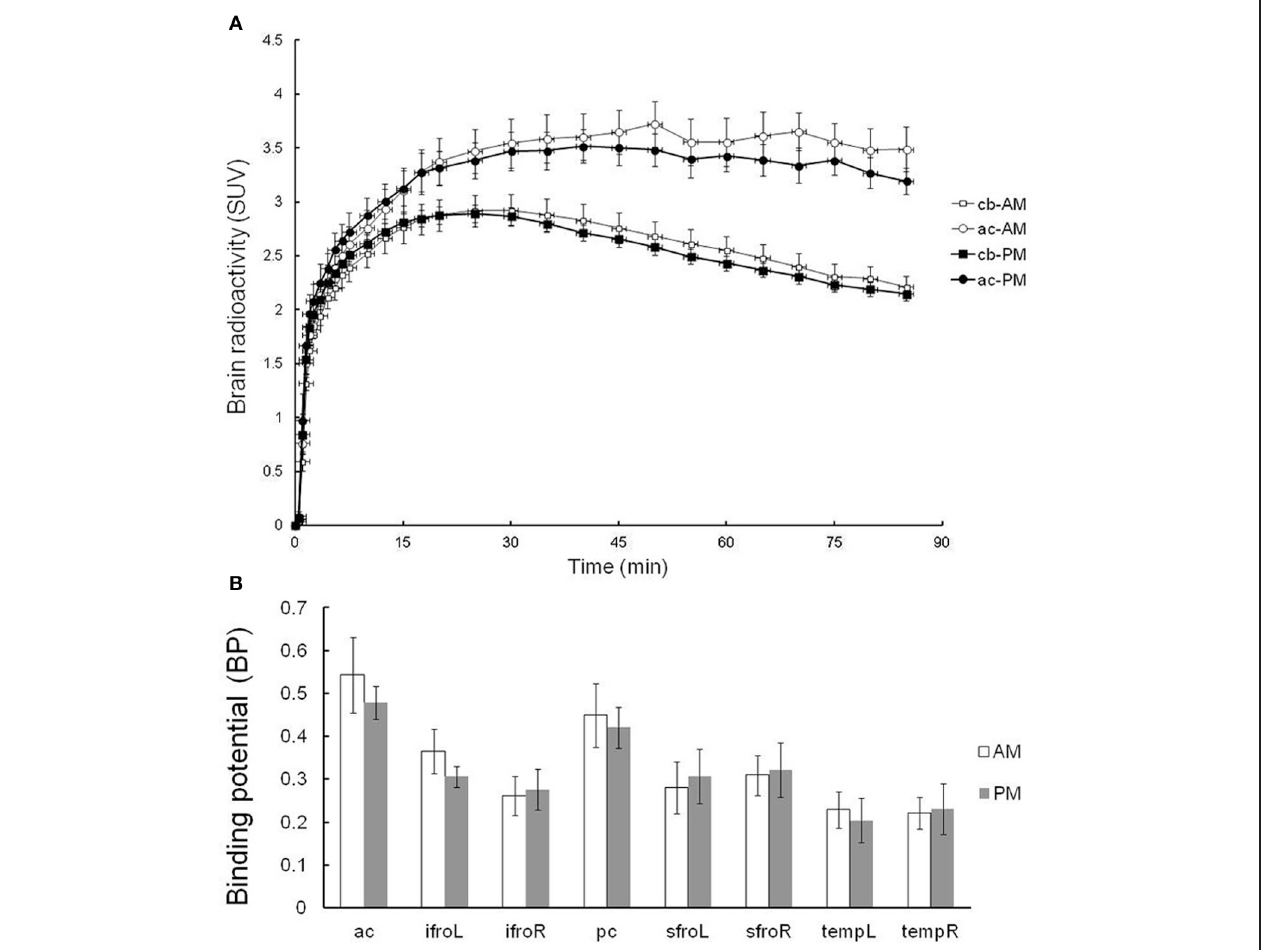
healthy male volunteers. (B) The binding potential (BP) in the test–retest trial. Abbreviations: ac, anterior cingulate gyrus; ifroL, left inferior prefrontal cortex; ifroR, right inferior prefrontal cortex; pc, posterior cingulate gyrus; sfroL, left superior prefrontal cortex; sfroR, right superior prefrontal cortex; tempL, left temporal cortex; tempR, right temporal cortex.